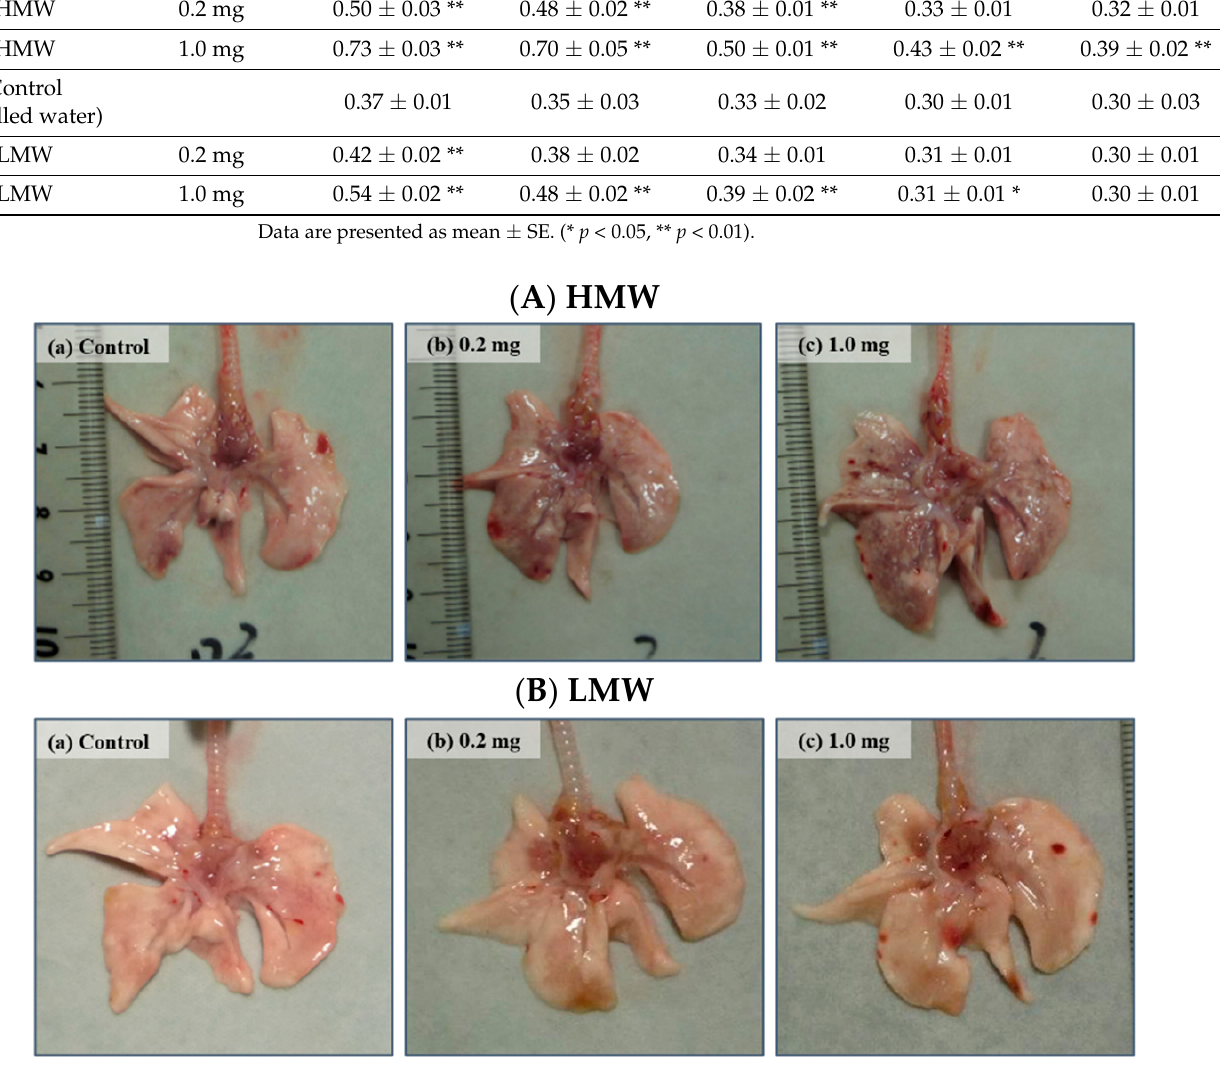
Figure 2. Macro findings at 3 days after instillation. The lungs in the exposed groups showed swelling at 3 days after intratracheal instillation. ( A ) HMW PAA-exposure group and ( B ) LMW PAA-exposure group, where ( a ) control group, ( b ) 0.2 mg-exposure group, and ( c ) 1.0 mg-exposure group. In the HMW PAA group, the surface of the lungs were rough. 2.3. Cell Analysis and Lactate Dehydrogenase (LDH) Activity in Bronchoalveolar Lavage Fluid (BALF) an index of cell injury, in the BALF. A significant increase in total cell count was